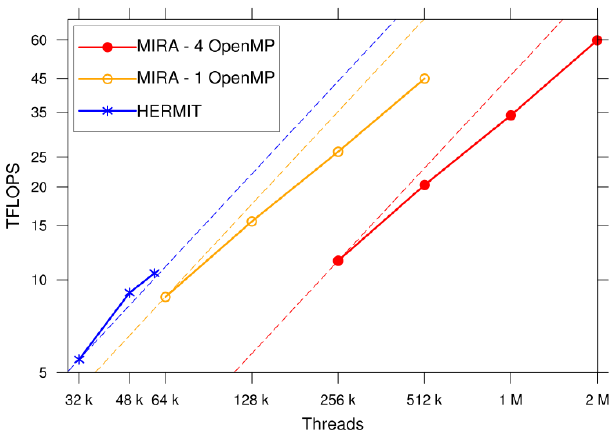
Figure 1. Performance of Meso-NH in scalability. Average sus- tained power (expressed in TFLOPS) depending on the number of threads obtained by Meso-NH for a grid of 4096 × 4096 × 1024 points (17 billion points) on two machines (HERMIT, a Cray XE6 in Germany, and MIRA, a IBM Blue Gene/Q in the USA, us- ing either one or four OpenMP tasks per core). The dashed lines show the optimal